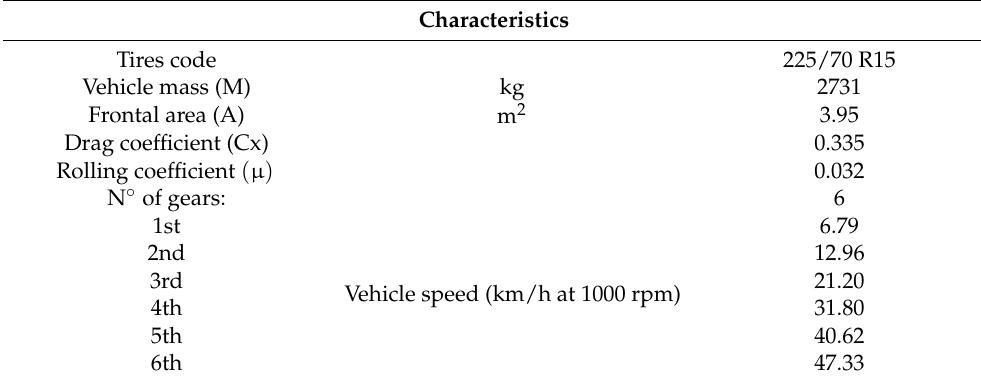
Table 2. Vehicle